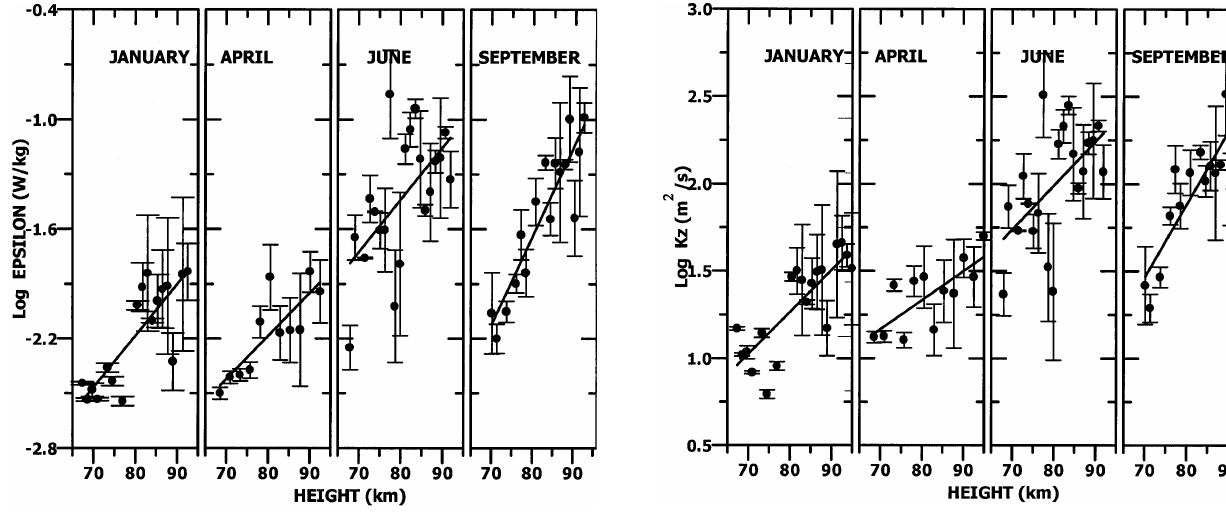
Fig. 1. Height variations of the kinetic energy dissipation rates ( ε ) in the mesosphere for the months of January, April, June and Septem- ber over Gadanki. Vertical bars show standard errors in ε values. The best-fit line for the height variation of ε is shown by a straight line.